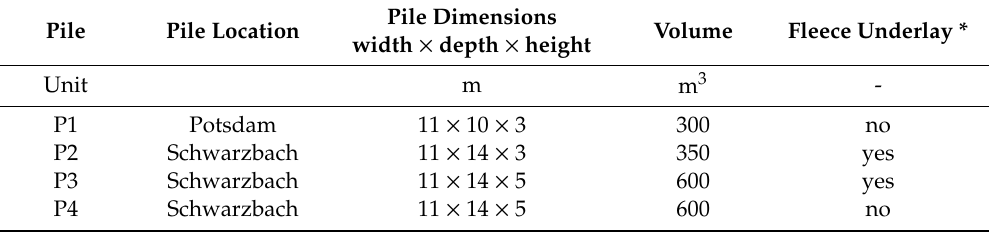
Table 3. Data on the storage pile structure for trials P1 in Potsdam and P2-P4 in